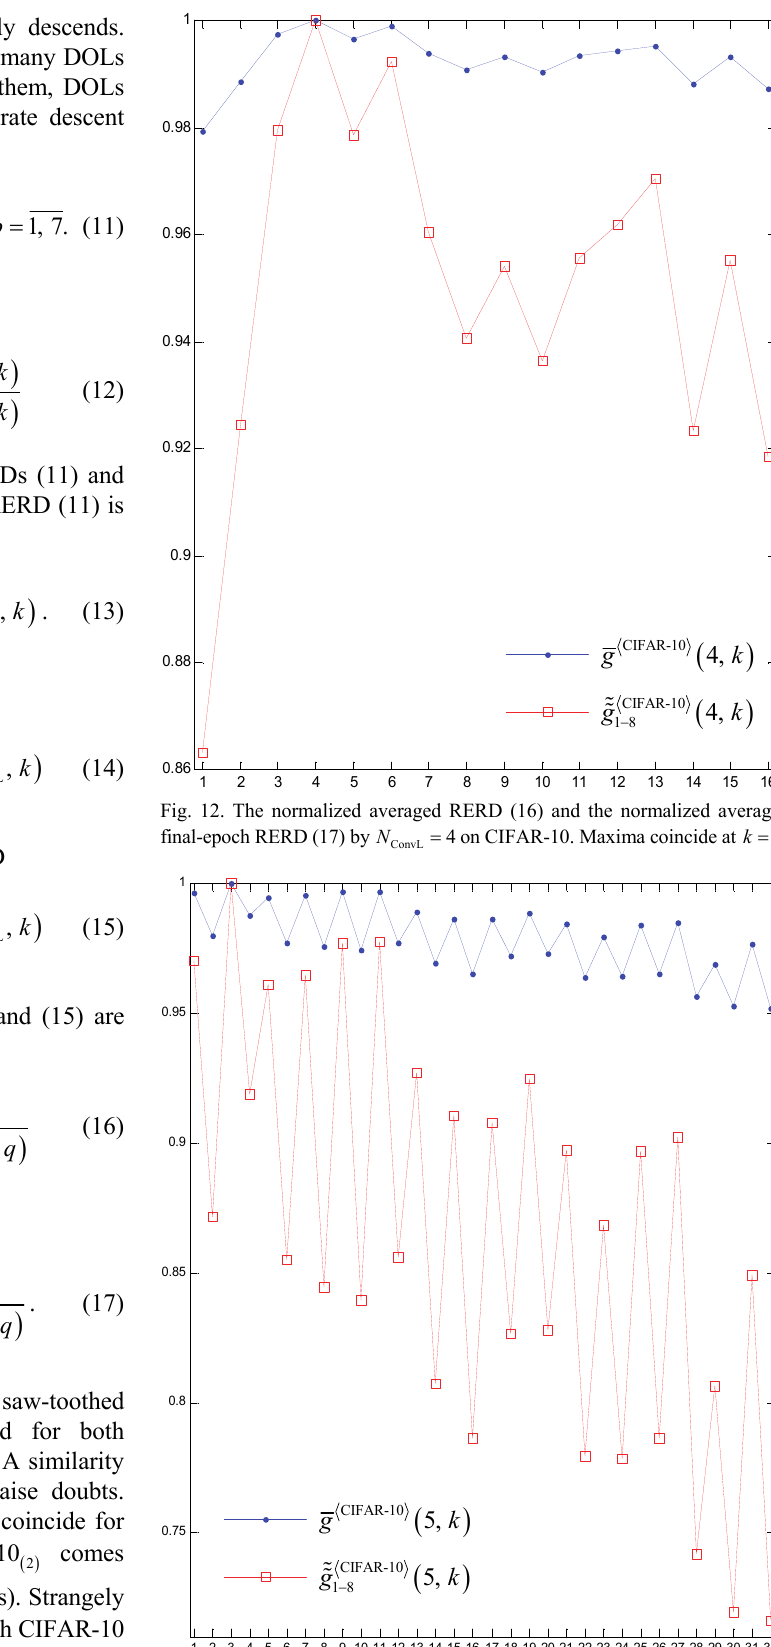
Fig. 13. The normalized averaged RERD (16) and the normalized averaged 5 N  on CIFAR-10. Maxima coincide at final-epoch RERD (17) by ConvL k = 3, but performance of CNNs without DOLs progresses closely to